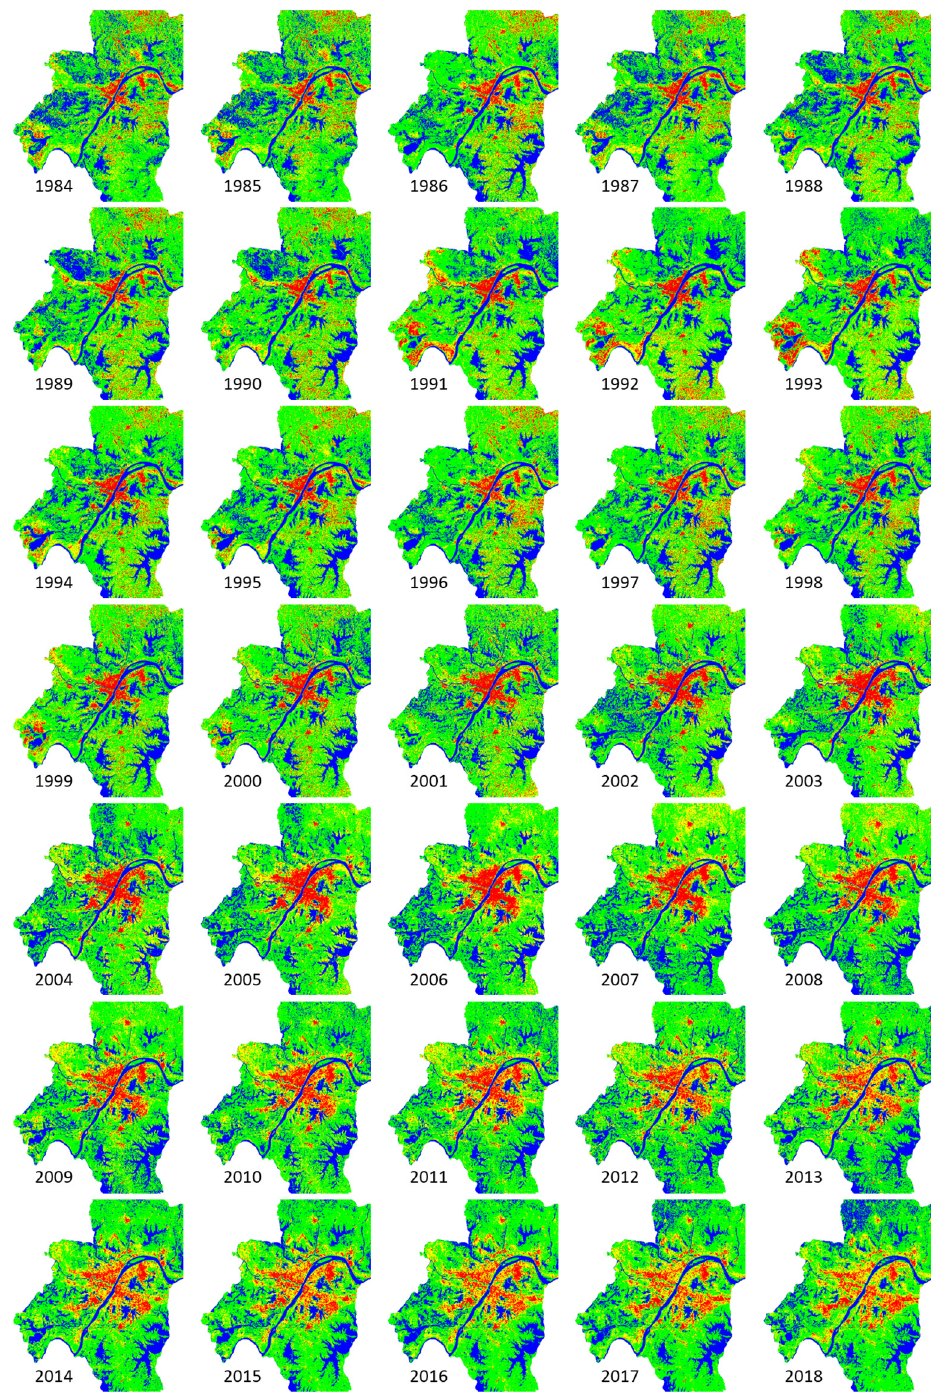
Figure 10. SUHI distribution in Wuhan from 1984 to 2018. For each image, the red area is the top 7.5% LST, the yellow area is the top 7.5–25% LST, the green area is the top 25–80% LST and the blue area is the last 20%